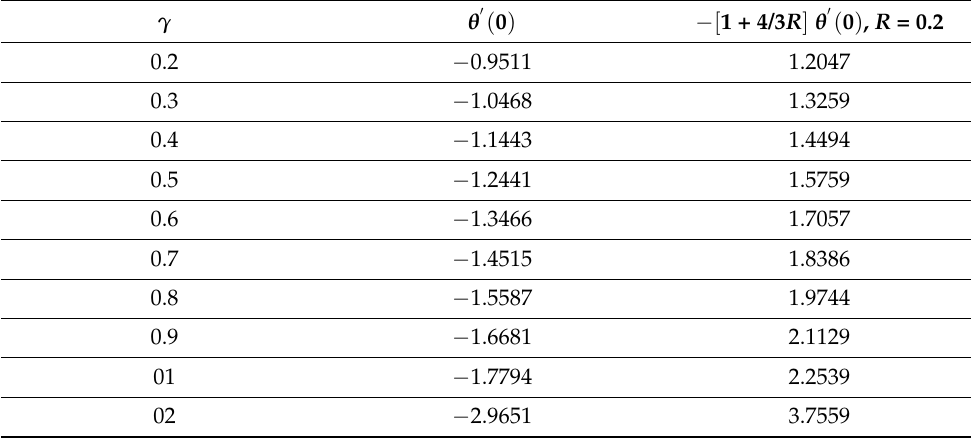
Table 4. Impact of curvature parameter on Nusselt number.